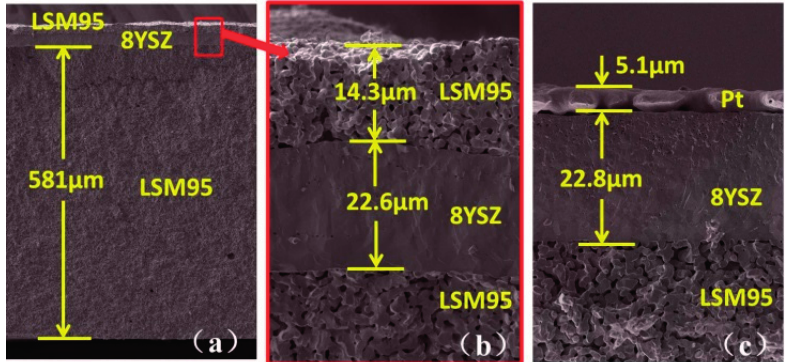
Figure 8. SEM micrographs of sensors, ( a ) Low magnification view of fractured S-LSM95; ( b ) High magnification view of S-LSM95; and ( c ) High magnification view of S-Pt.